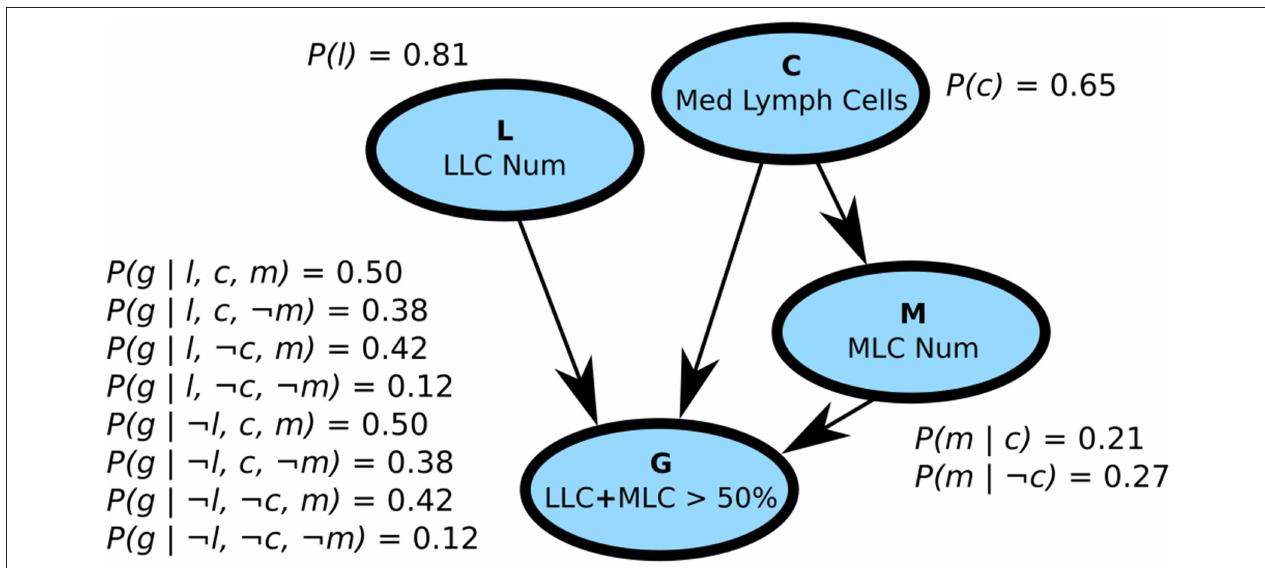
FIGURE 1 | A Bayesian network with four binary variables (the vertices) and possible conditional probability tables. Bayesian networks encode the distribution as directed acyclic graphs such that P (